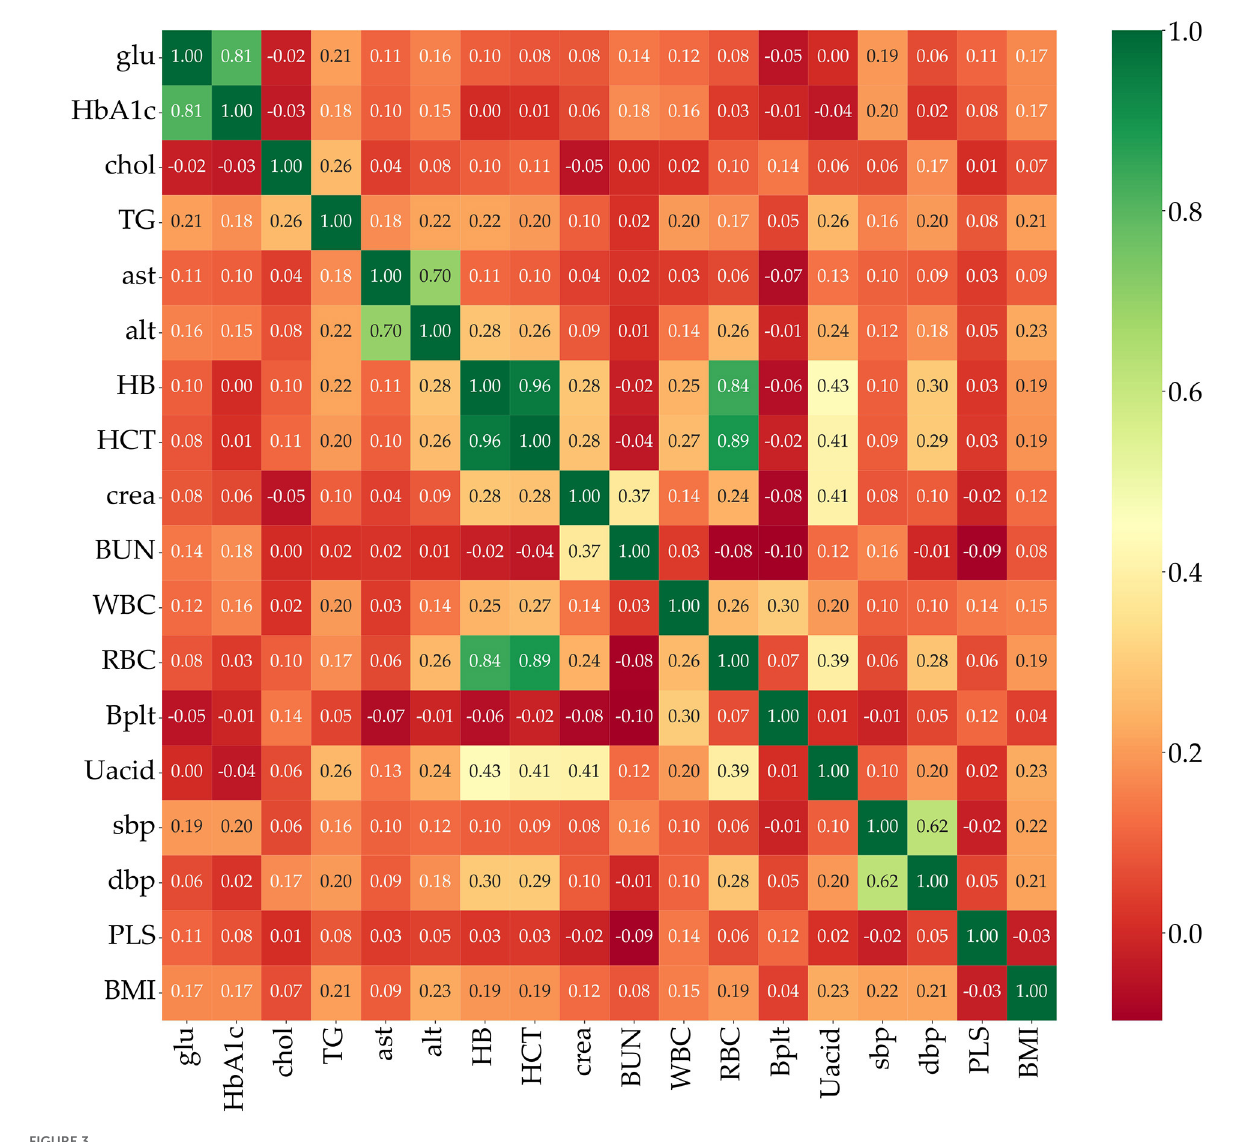
Table 4 defines sensitivity, specificity, and accuracy. F1-score is the measurement of the harmonic mean of recall and precision. The TP, TN, FP, and FN amounts are computed for each dataset using Table